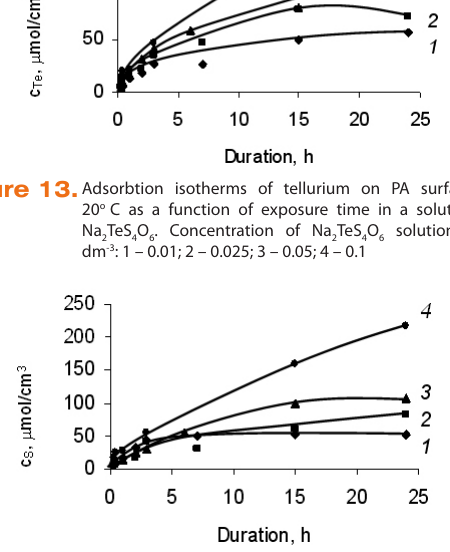
a function of exposure time in a solution of Na Concentration of Na 0.01; 2 – 0.025; 3 – 0.05; 4 –